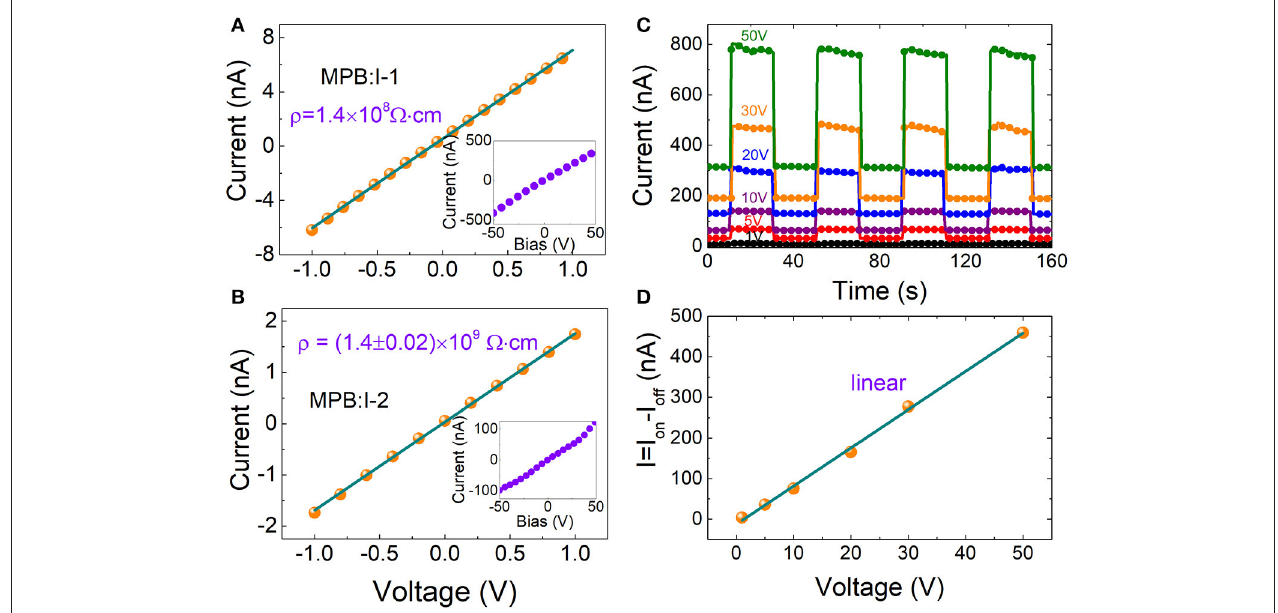
FIGURE 3 | The current–voltage curve from − 1 to 1V for (A) MPB:I-1 and (B) MPB:I-2. Inset is I – V curve from − 50 to 50V. (C) Photocurrent of MPB:I-2 under light pulses with 375nm and 14 mW/cm 2 measured under different biases. (D) The current ( I on – I off ) as a function of bias from 1 to 50V.